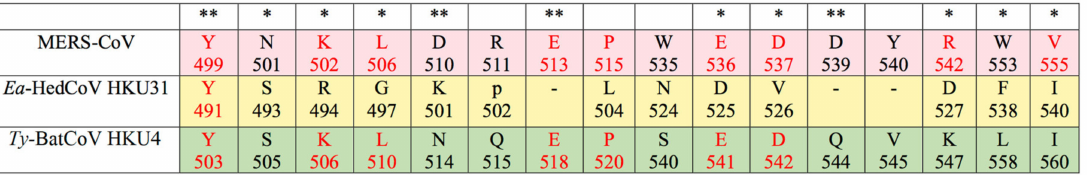
Figure 3. Multiple sequence alignment showing variations in key amino acid binding residues. Conserved residues are highlighted in red. Critical residues and critical bond formation residues are labelled with (*) / (**) respectively. Pink boxes refer to amino acid residues of MERS-CoV. Yellow boxes refer to amino acid residues of Ea -HedCoV HKU31. Green boxes refer to amino acid residues of Ty -BatCoV